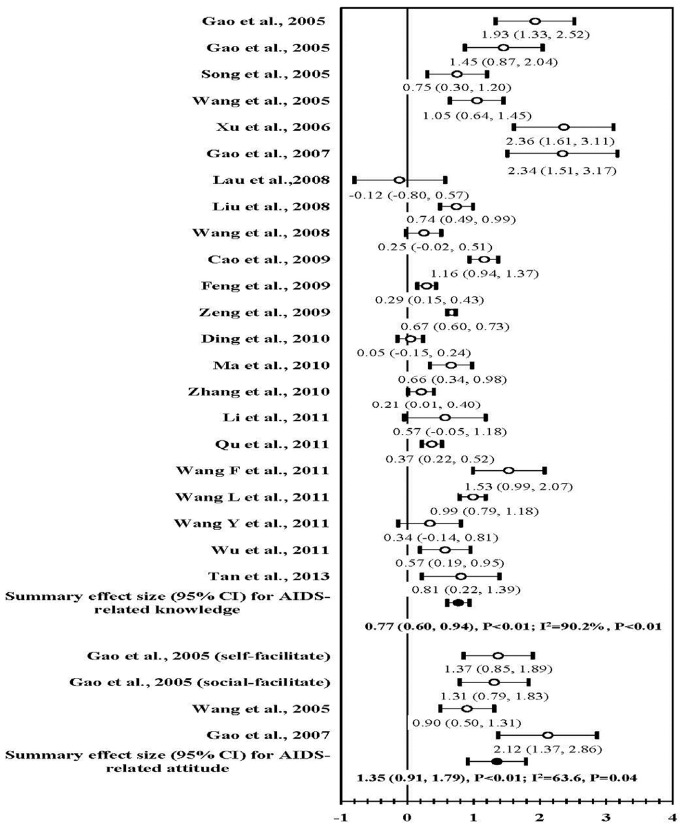
Forest plot of effect size: the impact of behavioral interventions on HIV/AIDS-related knowledge and attitude among MSM in China.